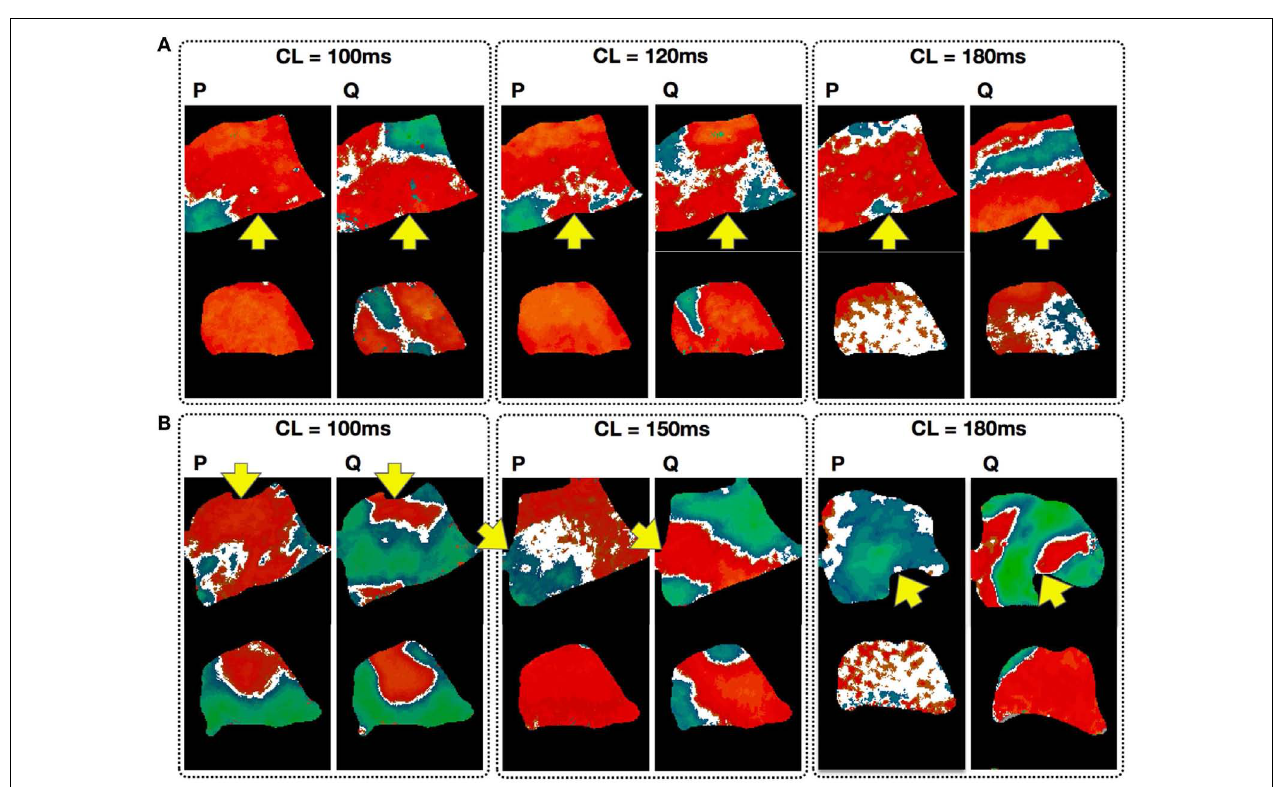
three CLs (100, 120, and 180ms). (B) Maps taken from different preparations with the patterns resulting from different pacing sites for three CLs (100, 150, and 180ms). Note that for the two cases with CL = 100ms, the difference in pacing site affects the spatial pattern produced although the tissue preparation is the